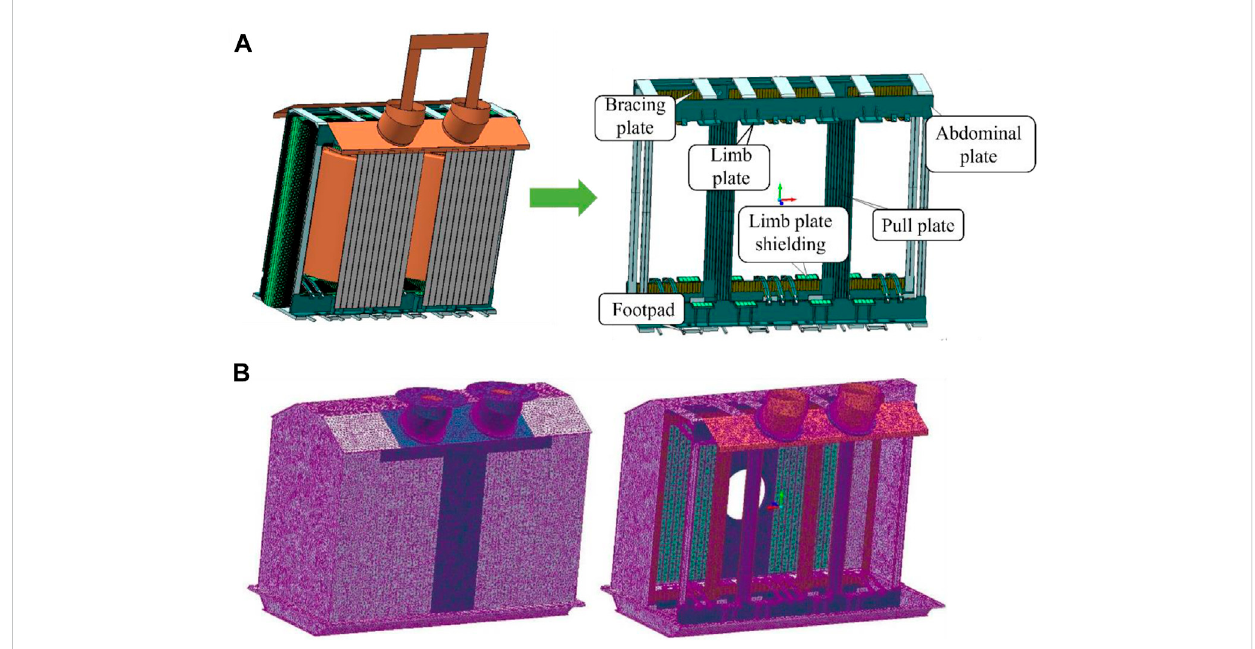
FIGURE 1 Model of oil-immersed transformer (A) Main structure of transformer (B) Grid of transformer fi eld thermal model.